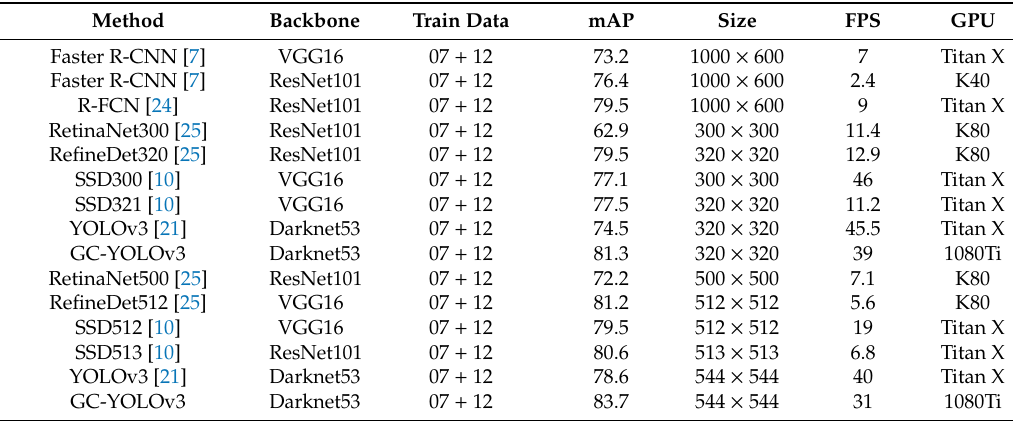
Comparison of di ff erent detection frameworks (including single-stage detector and Table 5. Comparison of different detection frameworks (including single-stage detector and double-stage detector) on the PASCAL VOC 2007 double-stage detector) on the PASCAL VOC 2007 test.